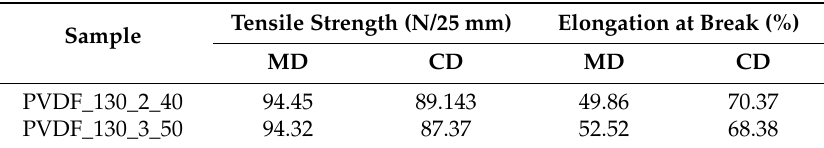
Table 1. Tensile properties of the two selected membranes.